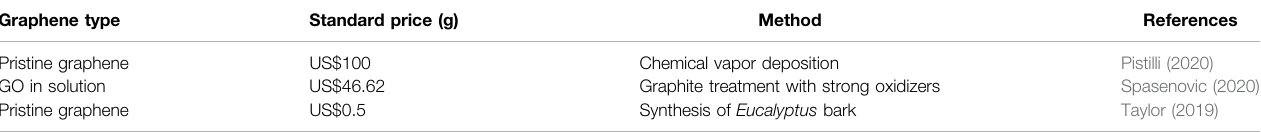
TABLE 8 | The cost of different types of